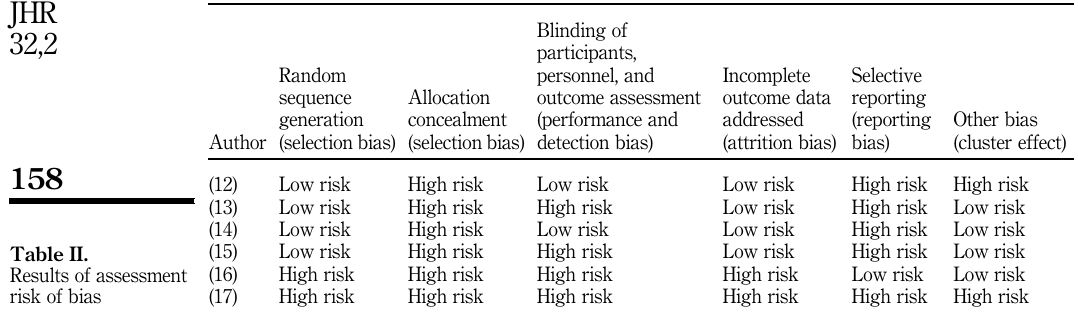
Table II. Results of assessment risk of